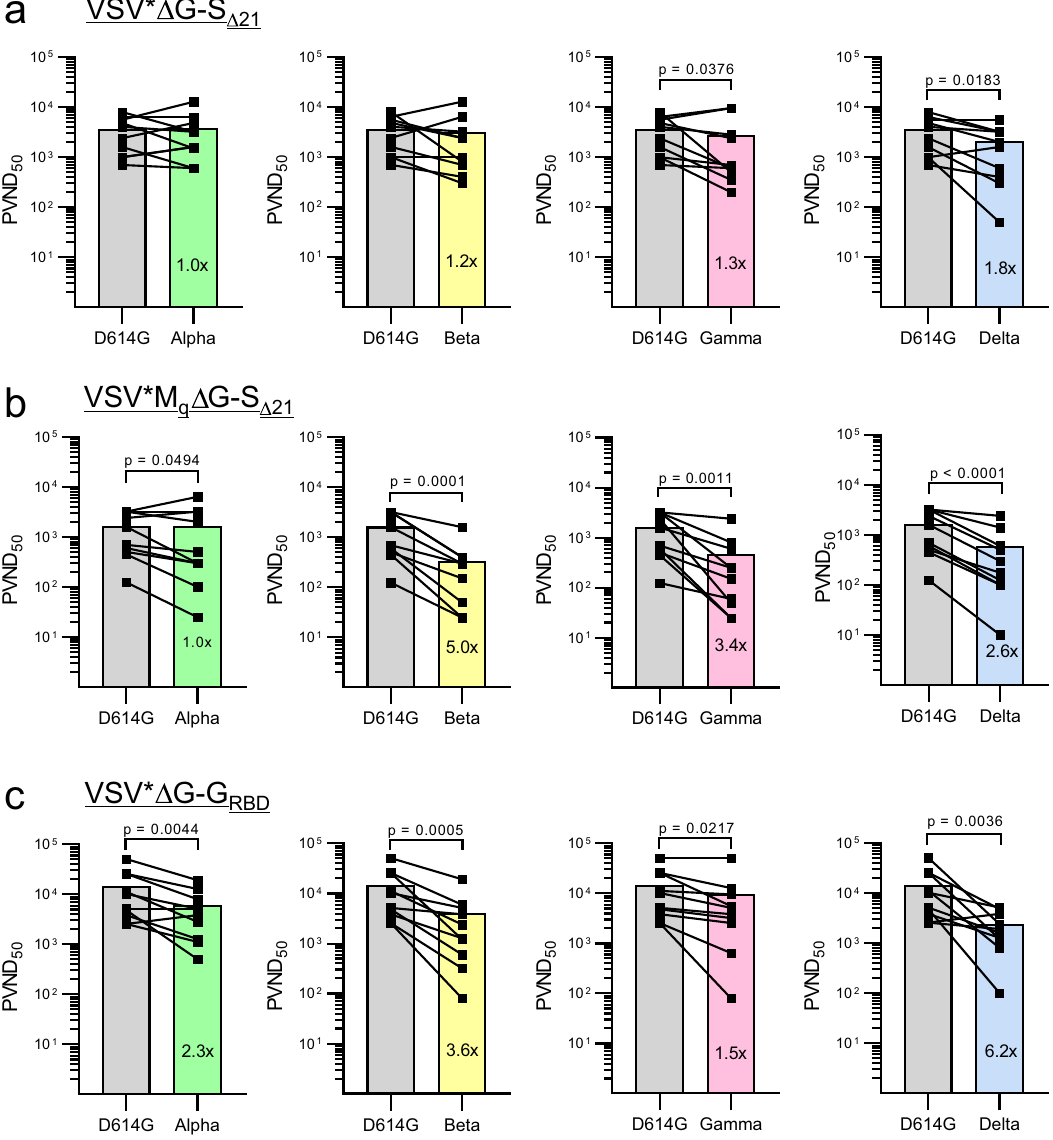
Fig. 6 Neutralizing antibodies induced by VSV-vectored vaccines differ in their capacity to block virus entry mediated by spike proteins derived from SARS-CoV-2 variants. Immune sera were prepared from K18-hACE2 mice 4 weeks after the second immunization with either ( a ) VSV* Δ G-S Δ 21 ( n = 10), ( b ) VSV*M q Δ G-S Δ 21 ( n = 10), and ( c ) VSV* Δ G-S RBD ( n = 5). Virus neutralization tests were performed using the VSV* Δ G(FLuc) vector pseudotyped with the S protein of the indicated SARS-CoV-2 VOC. At 20 h pi of Vero E6 cells, the reciprocal serum dilution causing 50% inhibition of the pseudotype virus-encoded fi re fl y luciferase reporter expression was determined and expressed as pseudotype virus neutralization dose 50% (PVND 50 ). Lines connect the corresponding PVND 50 titers of individual immune sera. The bars represent the mean neutralization titers. Statistically signi fi cant differences as determined by the two-tailed paired Student ’ s t test are